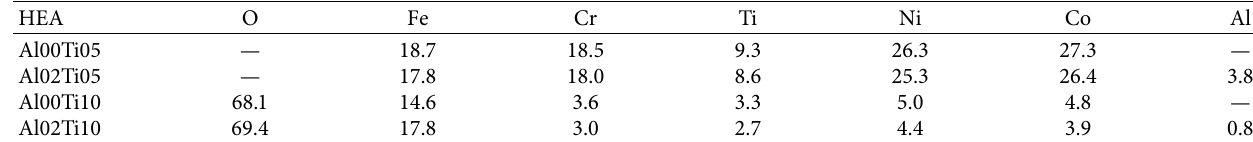
Figure 23: The worn-out surface morphology of Al 00 Ti 05 : (a) SEI and (b) BEI; Al 02 Ti 05 : (c) SEI and (d) BEI [33]. Table 3: Wear debris composition (in at. %) based on EDS analysis